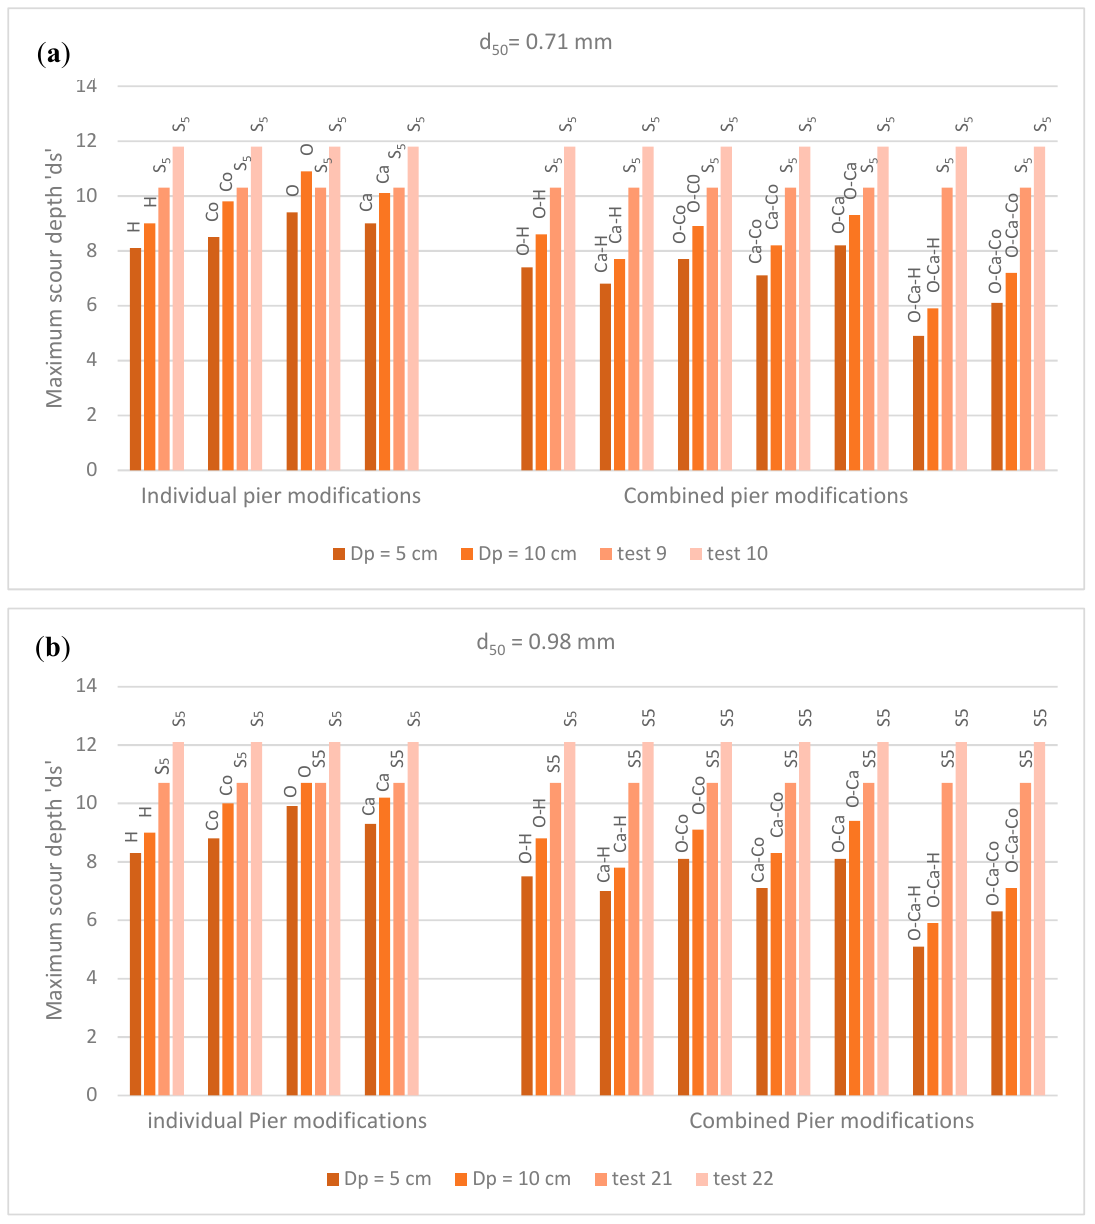
Figure 10. Comparison of maximum scour depth for protected and unprotected piers with different pier sizes: ( a ) d 50 = 0.71 mm, ( b ) d 50 = 0.98 mm.